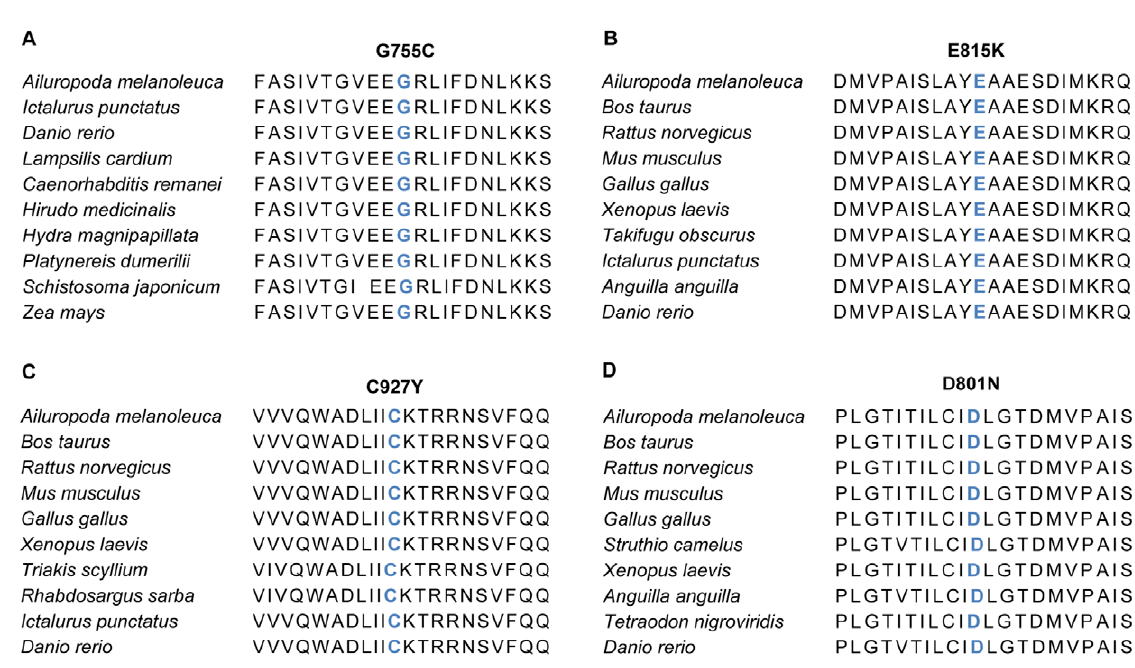
Figure 4. Homologous comparison of altering-protein. Blue letters: altering-protein by mutation, red letters: differential protein with human. (A) G755C changed by novel SNVs (c.2263G . T) of ATP1A3 in Patient I-1. (B) E815K changed by novel SNVs (c.2443 G . A) of ATP1A3 in Patients II-1, III- 1, IV-1, IX-1 and X-1. (C) C927Y changed by novel SNVs (c.2780 G . A) of ATP1A3 in Patient V-1. (D) D801N changed by novel SNVs (c.2401 G . A) of ATP1A3 in Patient VI-1, VII-1 and VIII-1.